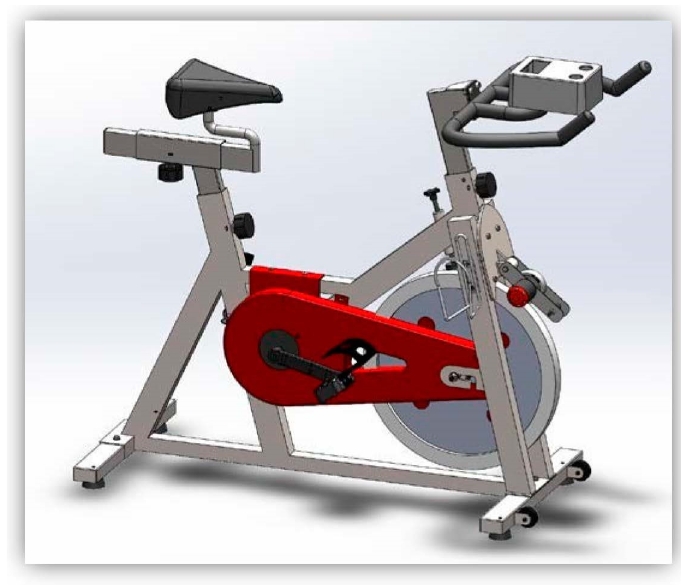
Figure 1. CAD model of a spin bike with an RC motor attached to the flywheel.